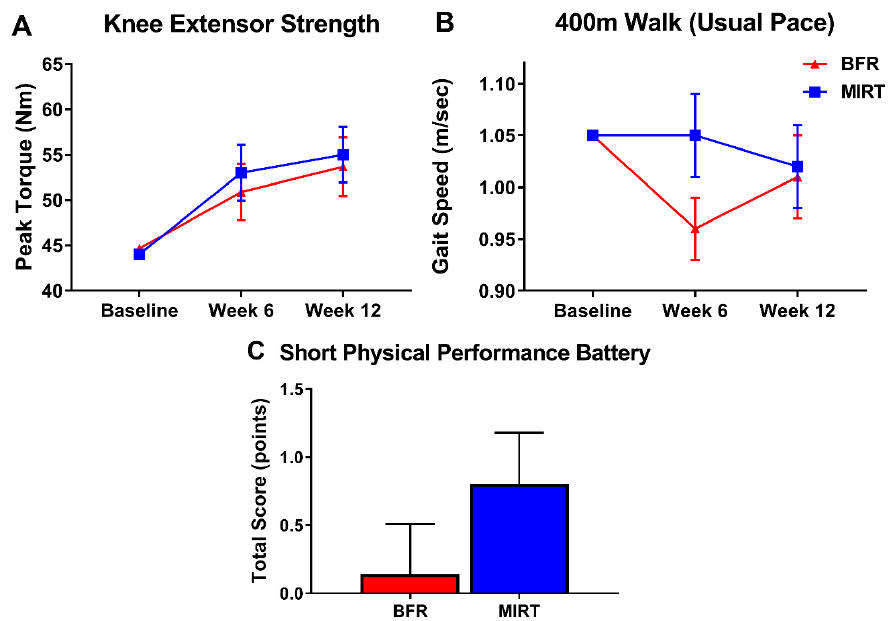
Figure 2. ( A – C ) Objective measures of physical function were evaluated from baseline to week 12 by mean composite unilateral knee extensor peak torque (Nm) across three speeds of movement (60, 90, 120 ◦ /s) ( A ), 400 m walk usual pace gait speed ( B ), and Short Physical Performance Battery ( C ). Values indicate estimated marginal mean ± SEM. Abbreviations: BFR—blood-flow restriction, MIRT—moderate-intensity resistance training.